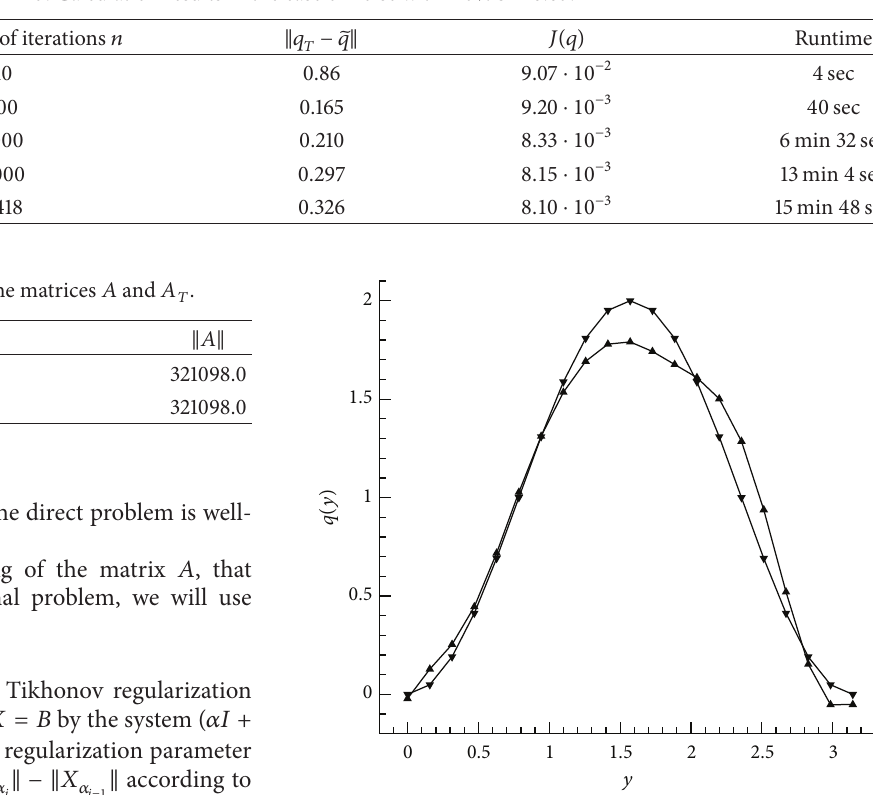
Table 3: Calculation results in the case of noise within 5% 𝜀 = 0.05 .